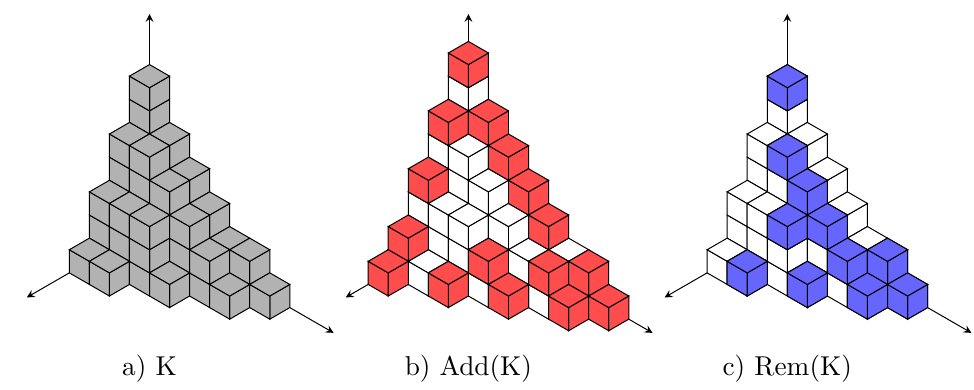
Figure 2 . Plane partition K = {{ 7 , 6 , 4 , 2 } , { 6 , 5 , 3 } , { 4 , 4 , 3 } , { 3 , 3 } , { 2 , 2 } , { 1 } , { 1 }} and sets Add(K) (red boxes) and Rem(K) (blue